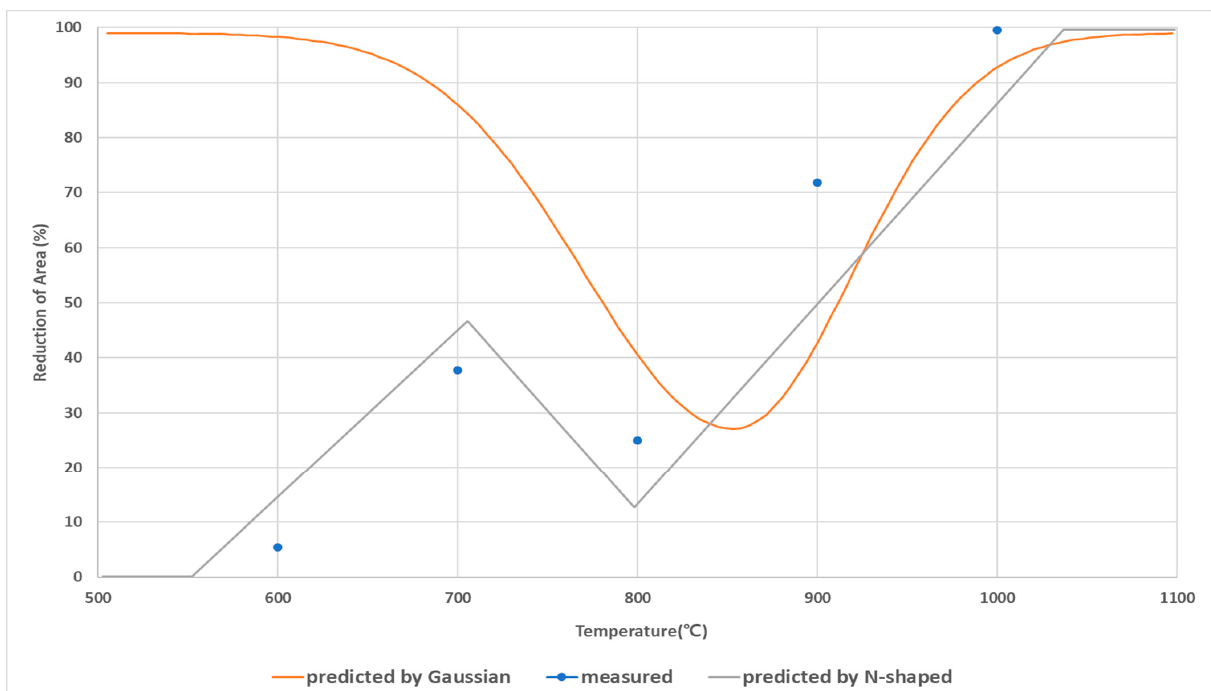
Figure 11. Comparison of RA prediction results of Gaussian and N -fitting models and measured RA values.